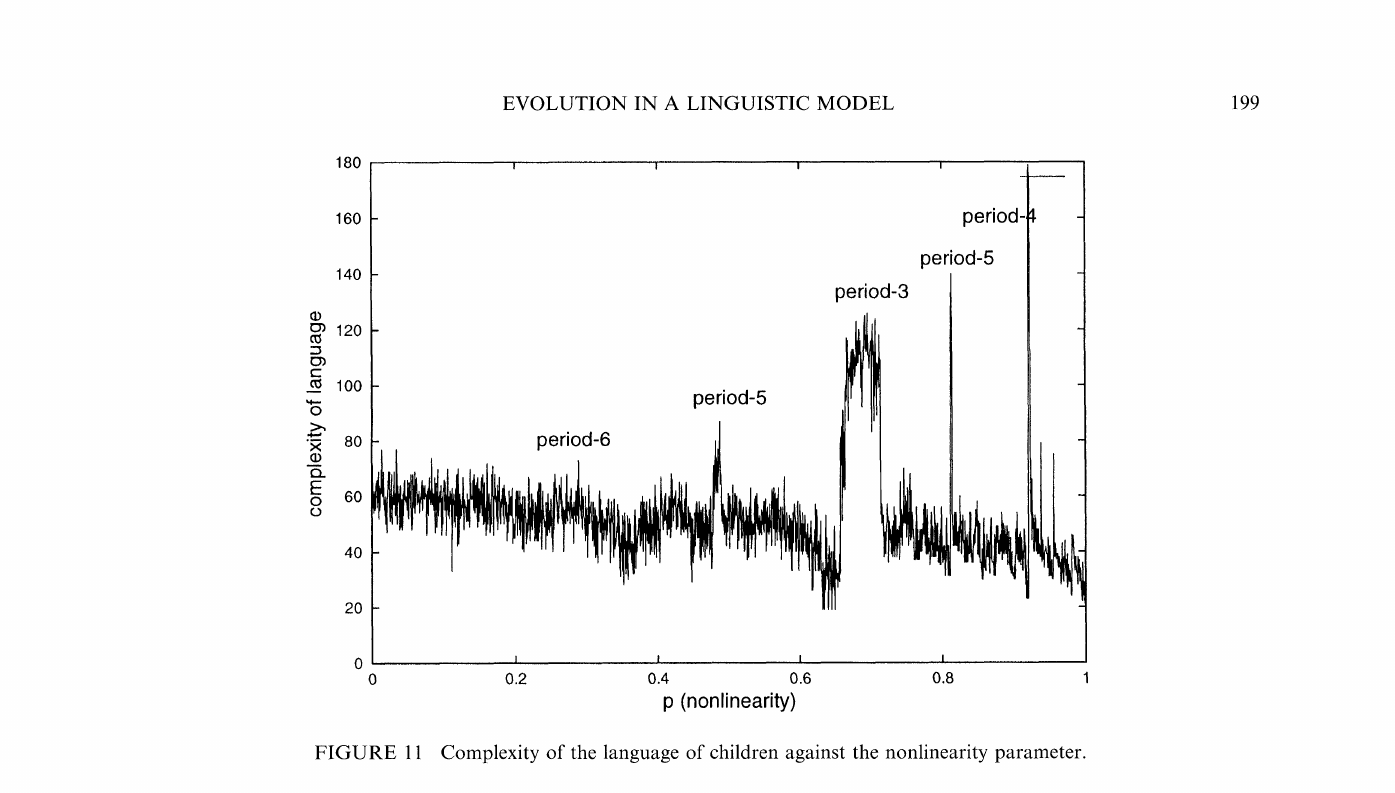
FIGURE 11 Complexity of the language of children against the nonlinearity